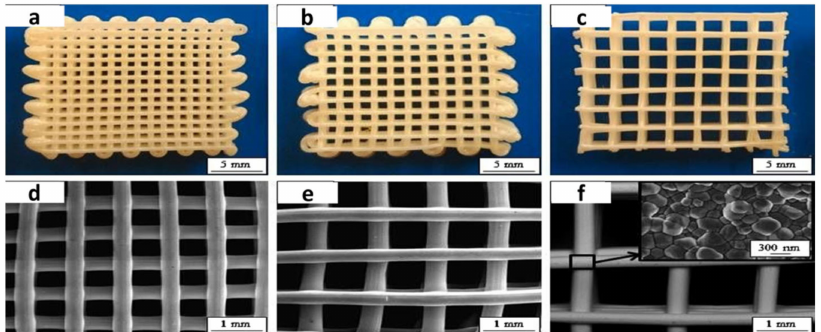
Figure 11. Optical images of 3D periodic zirconia scaffolds with different minimum separation distances between rods ( a ) 0.7 mm, ( b ) 0.9 mm and ( c ) 1.8 mm and corresponding top-surface images ( d – f ), respectively. The inset SEM image shows the high degree of sintering achieved within the filaments. Image used from Kocylo et al. [86] reprinted with permission from Elsevier, copyright© 2021.